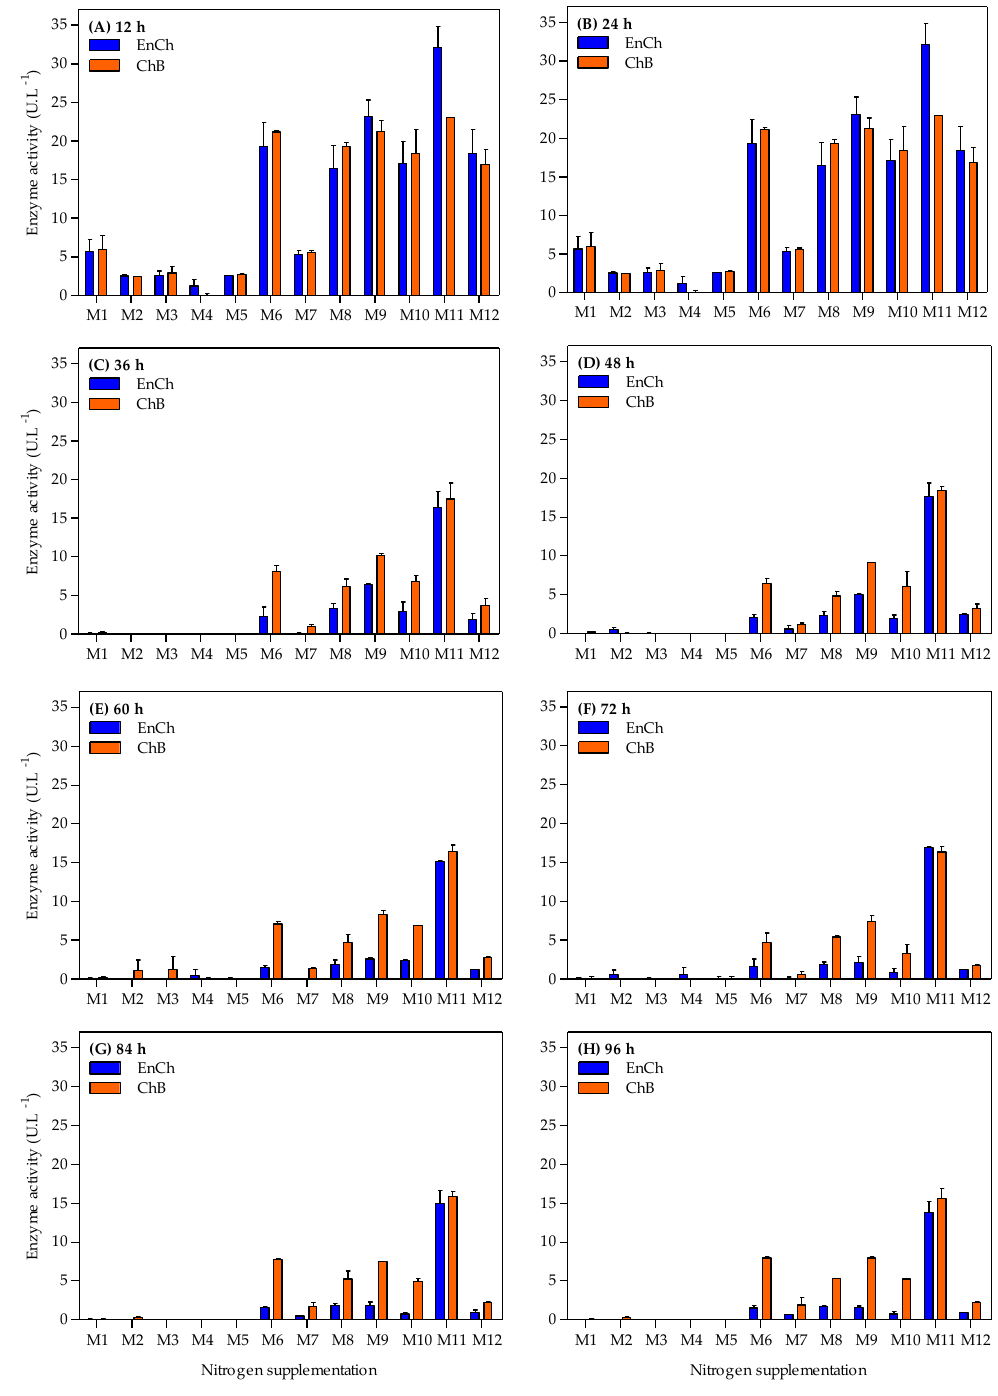
Figure 3. Time-course profiles of endochitinase (EnCh) and chitobiosidase (ChB) activity during Aeromonas caviae CHZ306 cultivation in the chitin-containing medium under different nitrogen supplementations (viz. M1–M12). M1 (ammonium sulfate), M2 (ammonium acetate), M3 (ammonium nitrate), M4 (urea), M5 (casaminoacids), M6 (meat extract), M7 (yeast extract), M8 (peptone Bacto), M9 (peptone A), M10 (peptone G), M11 (corn-steep solids), and M12 (tryptone). All data represent the mean ± standard deviation (sd).